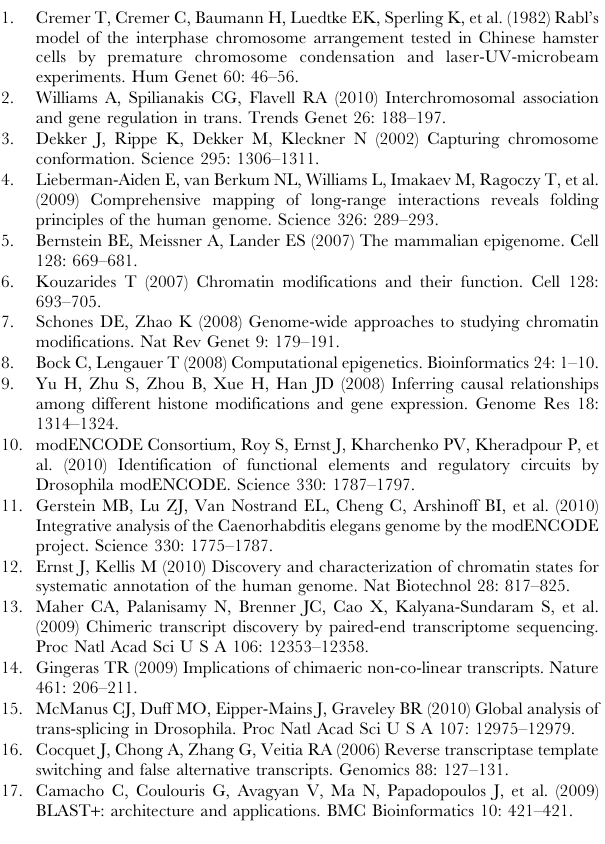
Table S1 The RMSE of regression models, which use one feature separately to predict spatial proximity, compared to the RMSE of the algorithm which uses training set mean as the predicted value. The significance of the difference between each feature-based model and the mean-based algorithm was estimated by p-values of paired, two-sample, two-tailed T-test with the Bonferroni correction, which are shown right to the corresponding model errors. Bold font shows features, for which the regression models have larger error than the mean-based algorithm. Italic font shows non-significant differences. Table S2 The list of DNA fragments clustered into 4, 8, 16, 32, and 64 groups by the spatial